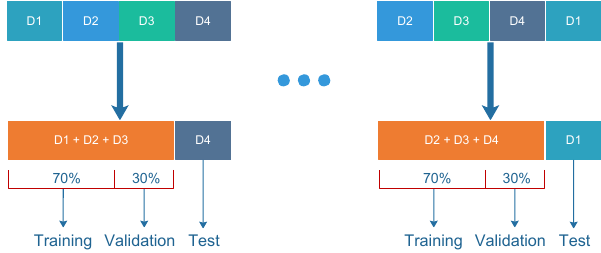
Figure 5. The k-fold cross-validation process. A fourfold cross-validation was performed to test the complete dataset, where each fold is the out-of-sample dataset at a time. The validation partition is used to validate the trained model during the multi-objective optimization